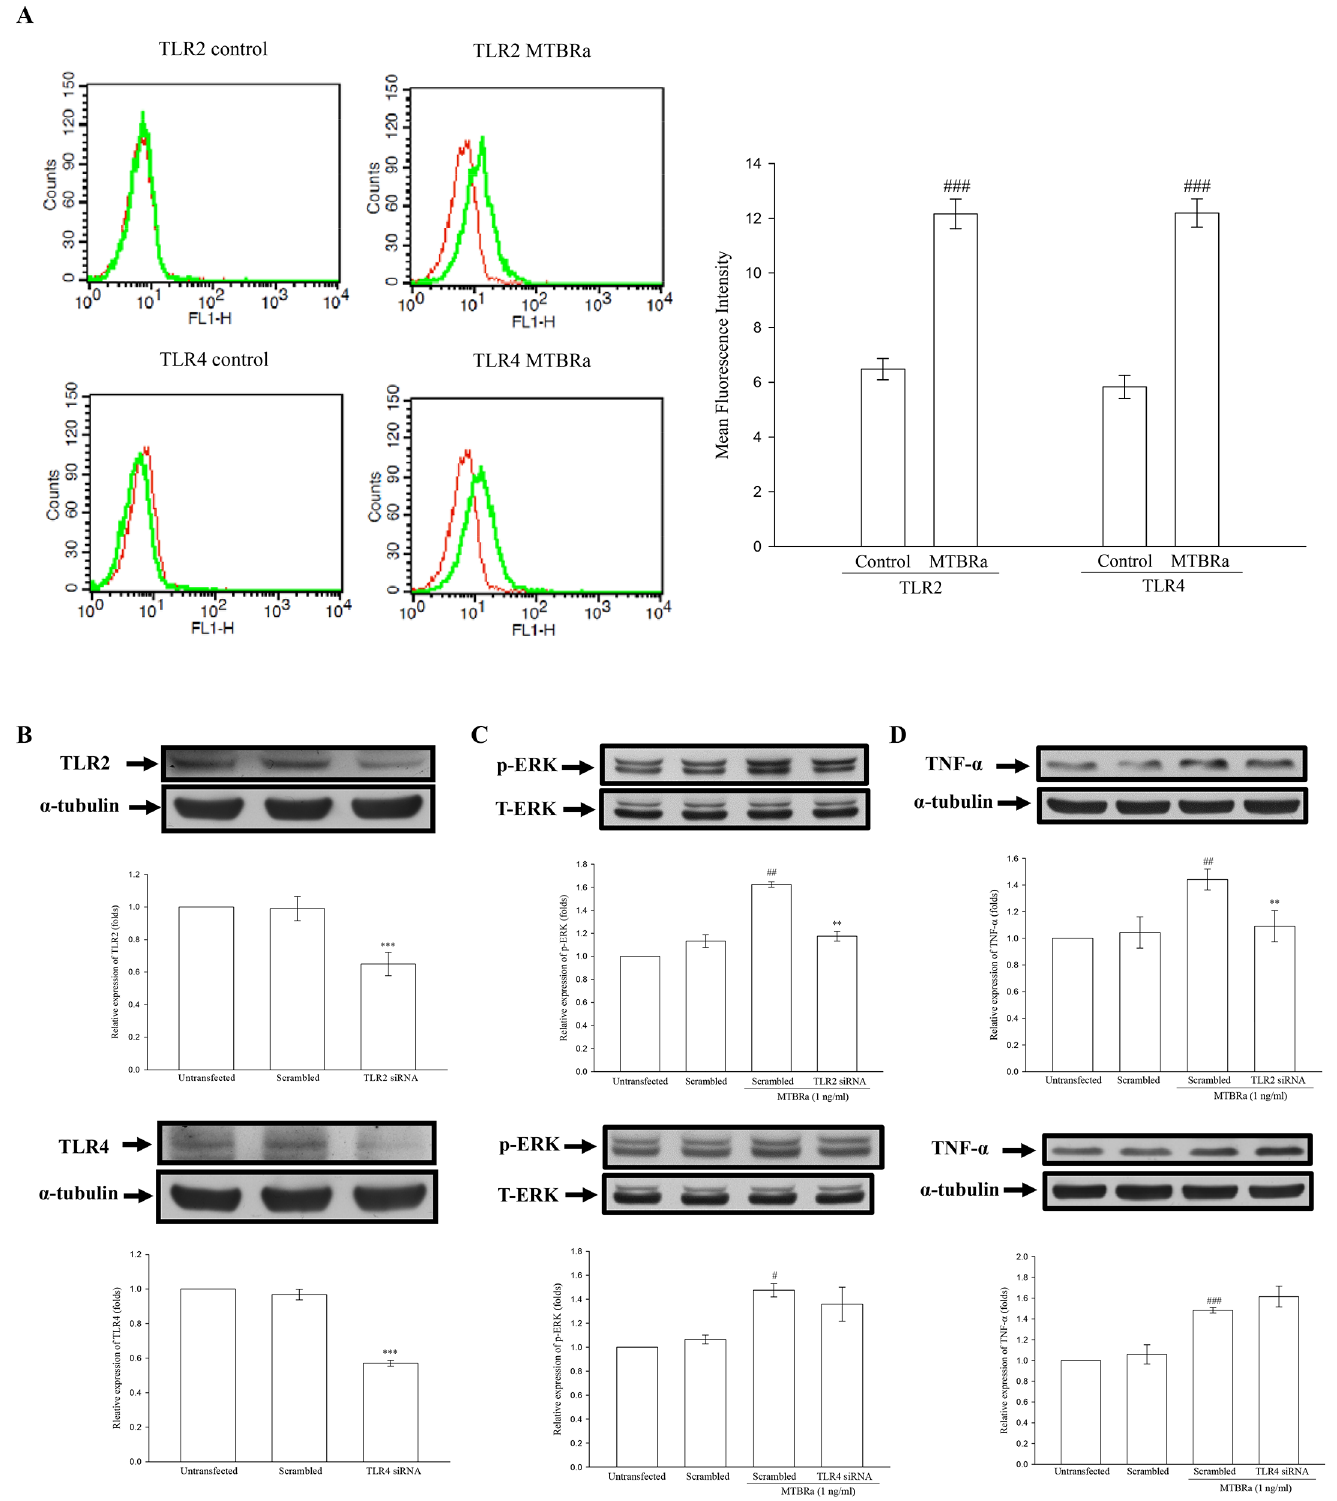
Fig 5. TLR/ERK Signaling Activating TNF- α Expression in MTBRa-Stimulated Human PMCs. (A), Flow cytometric analyses of expression of TLR2 or TLR4 (green) on cell surface of MeT-5A cells treated with MTBRa (1 ng/ml) for 3 h or left untreated (control). Isotype control IgG (red). Quantitative analysis of TLR2 or TLR4 expression was expressed as percentage of the total cells. A representative of three experiments is depicted. ### p < 0.001 compared with the